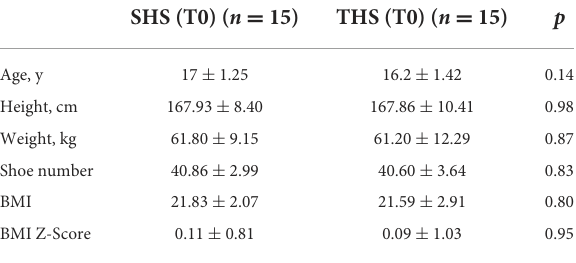
TABLE 1 Unpaired t -test analysis of the anthropometric measures between SHS (T0) and THS (T0).